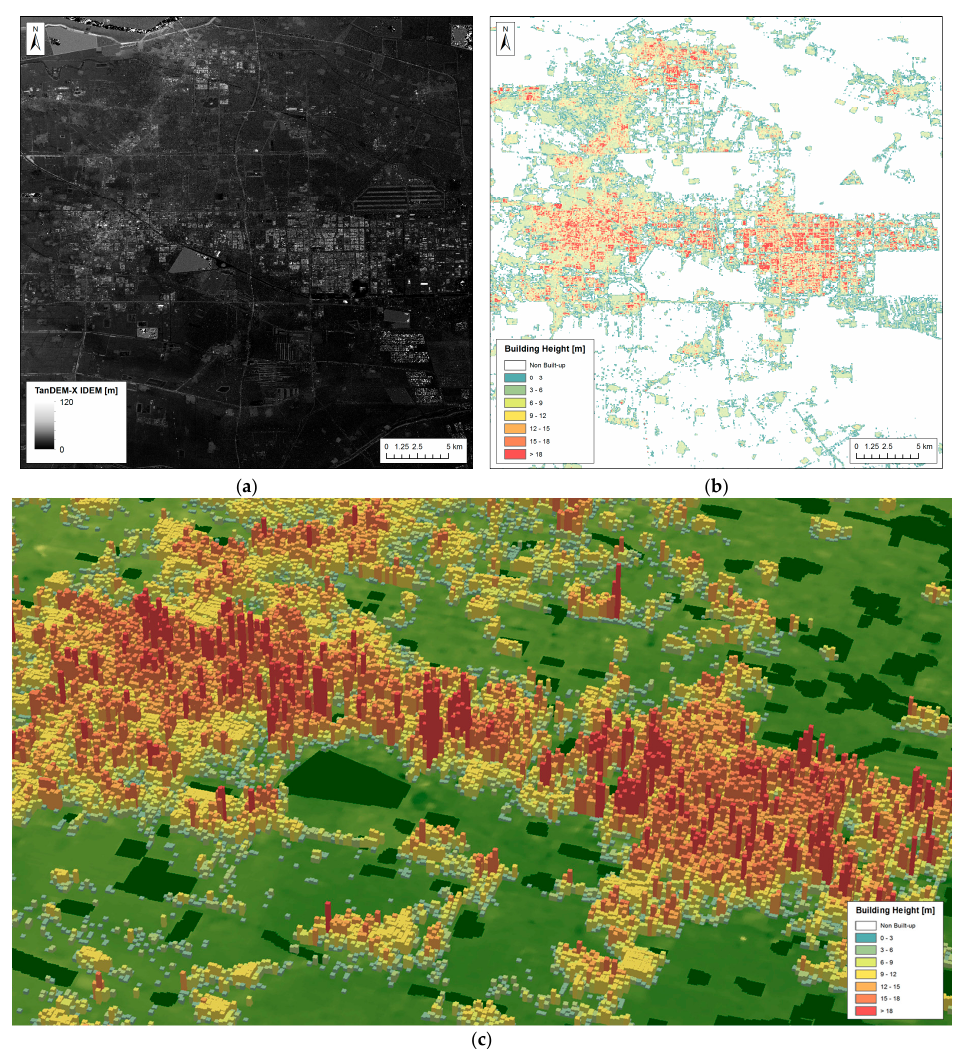
Figure 8. Dongying (China)—quicklook of the TanDEM-X DEM ( a ) and corresponding building height estimated with the implemented methodology in 2D ( b ) and 3D ( c ),